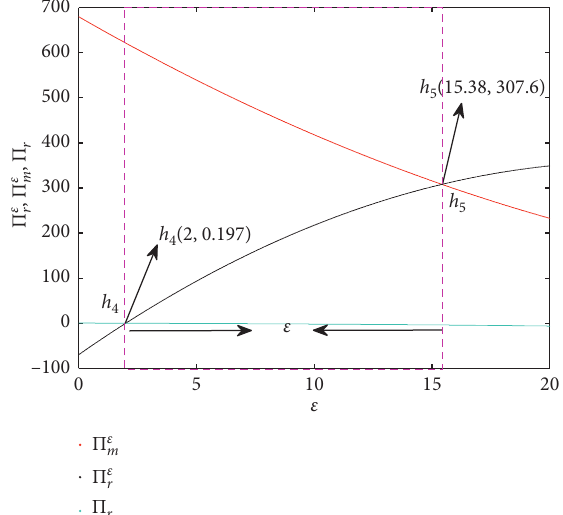
Figure 26: The Stackelberg equilibrium ( w, p spect to s .